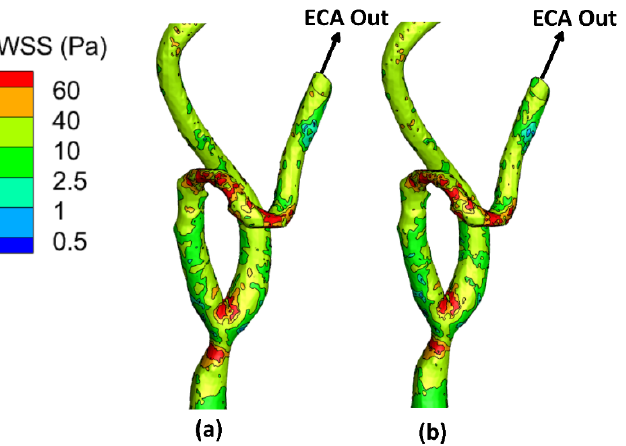
Figure 6. WSS contours for stenotic CCA (model C) of the CA at the peak systole of the cardiac cycle: ( a) elastic wall, ( b ) rigid wall.